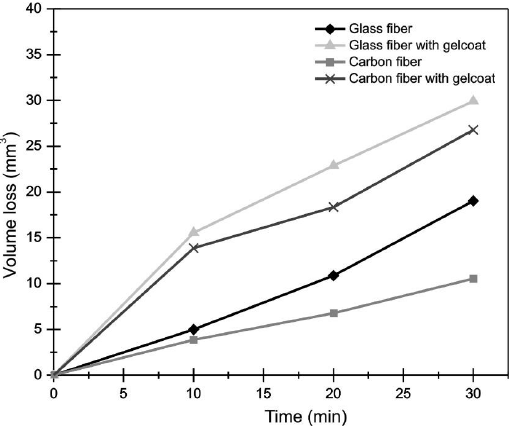
Figure 10. Volume loss during the liquid erosion test with 75° impact angle.